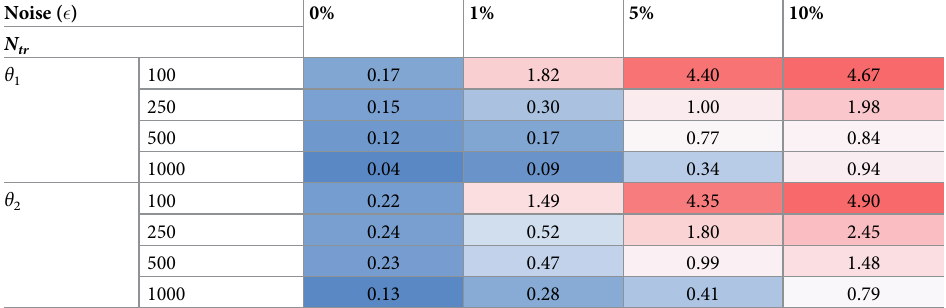
Table 4. Diffusivity equation—inverse modeling: PINN performance as function of noise. This figure shows the average percentage errors of θ 1 and θ 2 for different numbers of training data, N tr , as function of the noise levels. Here, the neural network architecture is kept fixed to 6 layers and 5 neurons per layer. The results are averages over 10